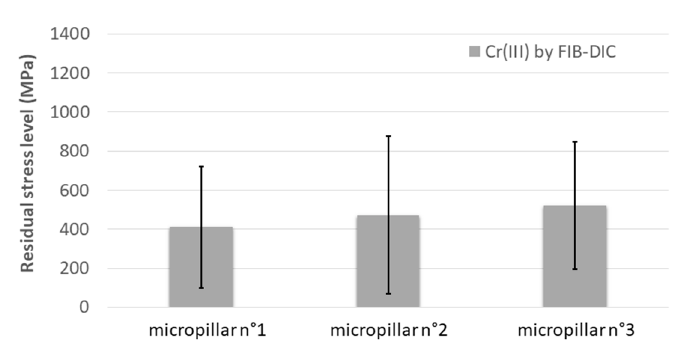
Figure 10. Results of FIB-DIC residual stress level measurements on untreated trivalent chromium samples 1 to 3. Error bars correspond to one standard deviation.